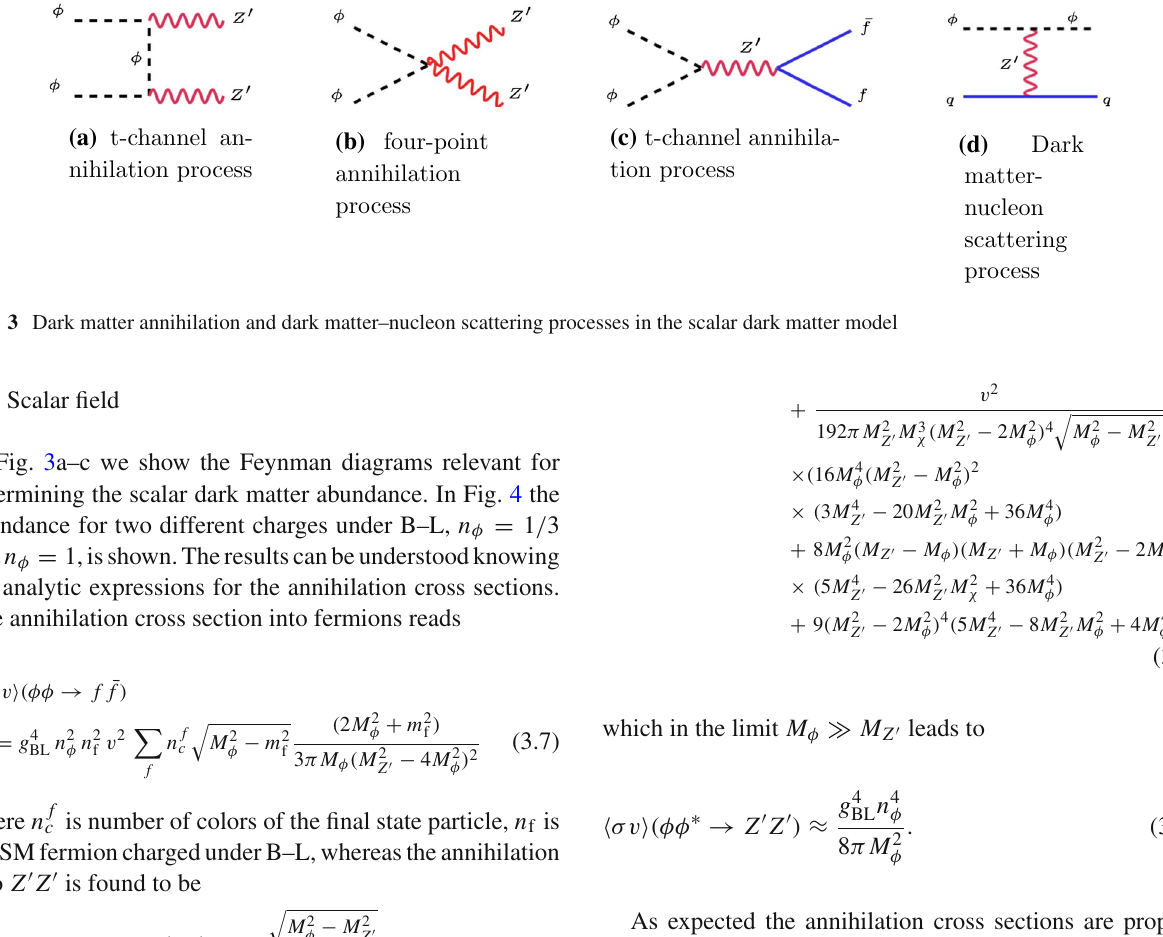
Fig. 2 Dirac fermion. Abundance as a function of mass for various gauge couplings and Z (cid:2) boson masses. Because the model must satisfy the relic density, it features a strong dependence in the resonance region